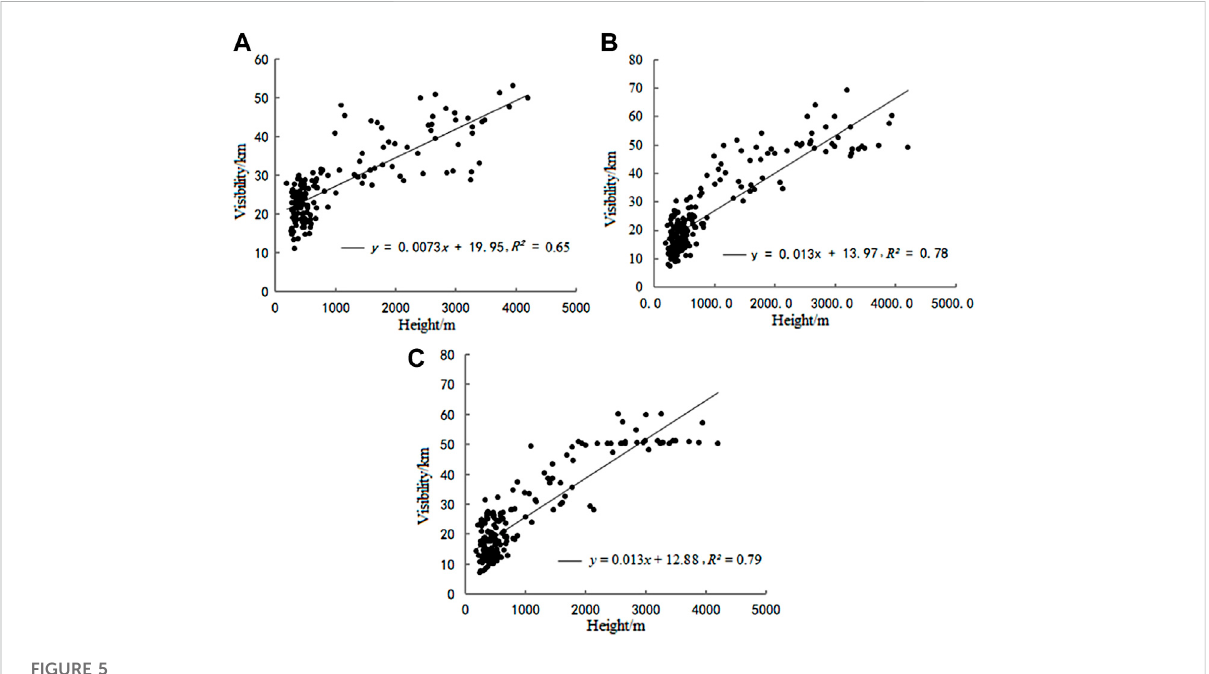
FIGURE 5 Scatter plots and correlation coef fi cients ( R ) of the visibilities and terrain heights over the years from (A) 1960 to 1970, (B) 1980 to 1990, and (C) 2000 to 2010, respectively. There are 191 scattered points in each of the three subplots, representing the values of 191 meteorological observation